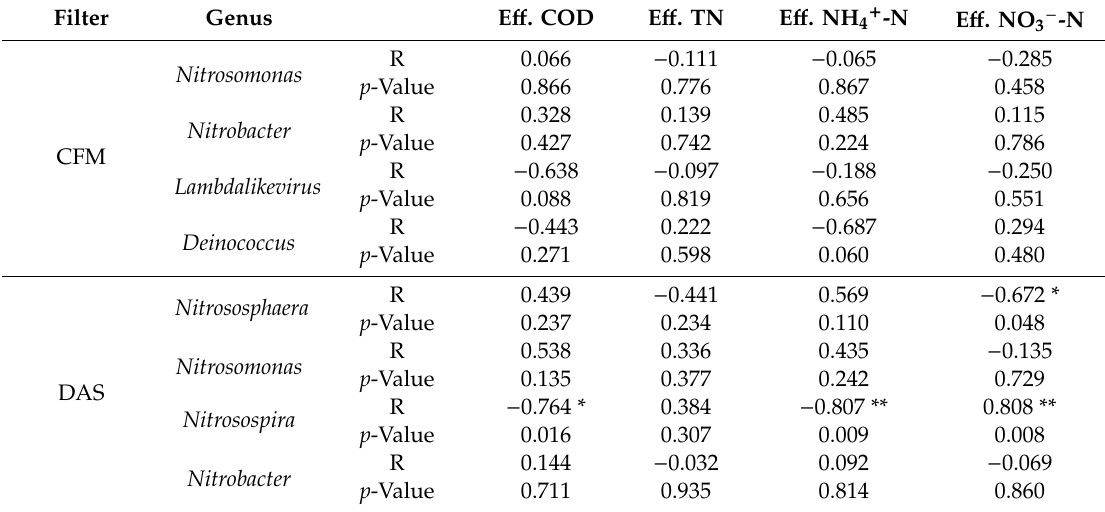
Table 2. Pearson correlation coe ffi cients (R) between the relative abundances of the dominant genera and e ffl uent wastewater concentrations factors in CFM and